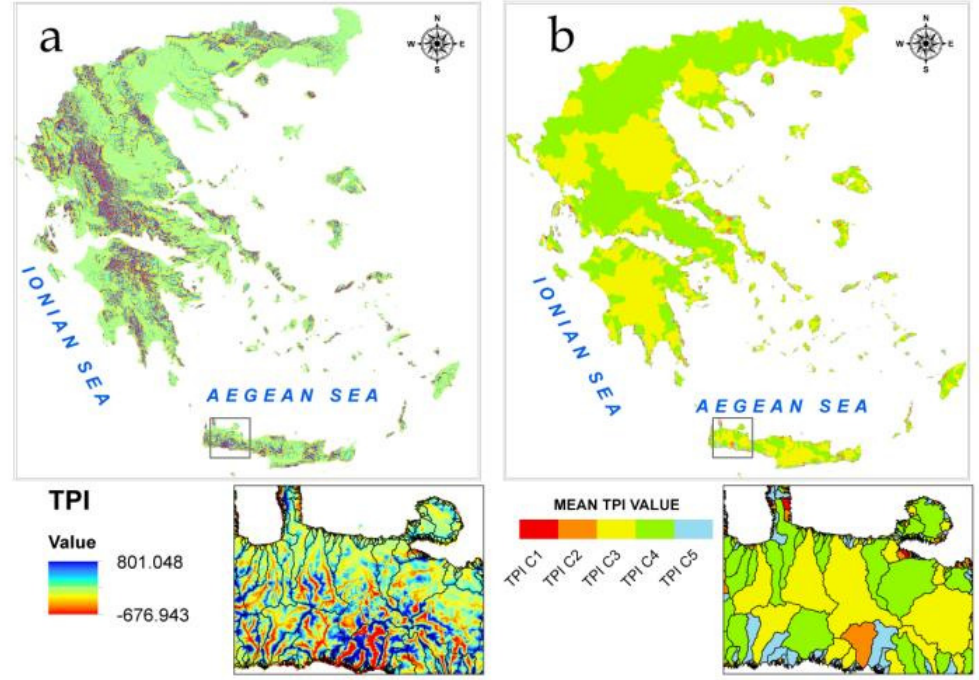
Figure 4. ( a ) TPI values in Greece at a scale of 2000m. Inset: Detail of the TPI map with drainage basins overlay, ( b ) Quantile classification of drainage basins according to their mean TPI value. Inset : detail of the map.